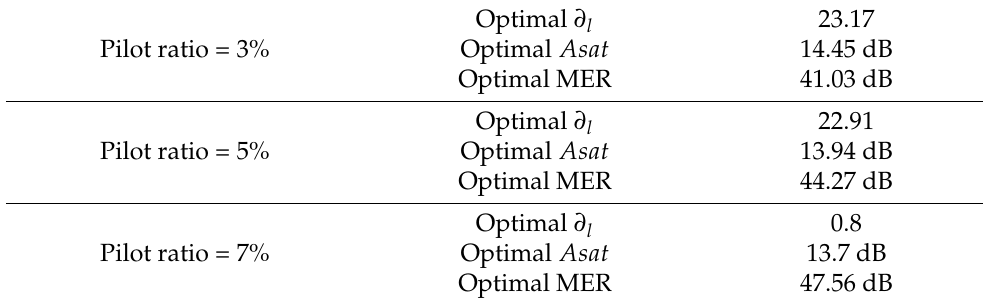
Table 3. Results of